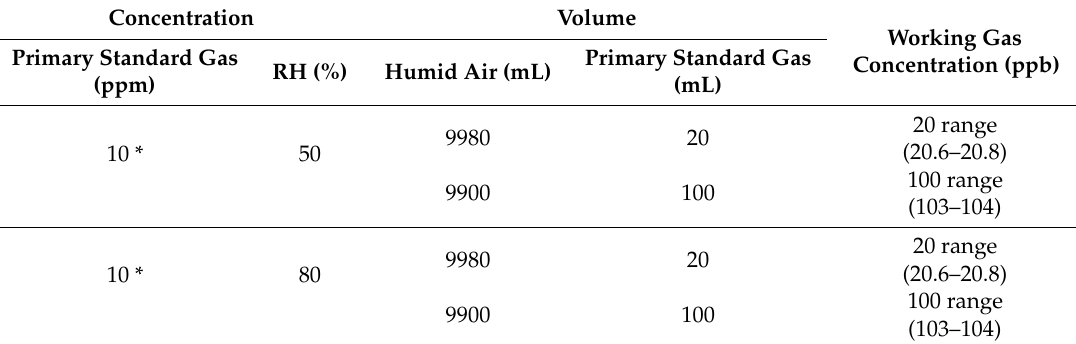
Table 3. Dilution method for recovery experiment by water pretreatment devices.